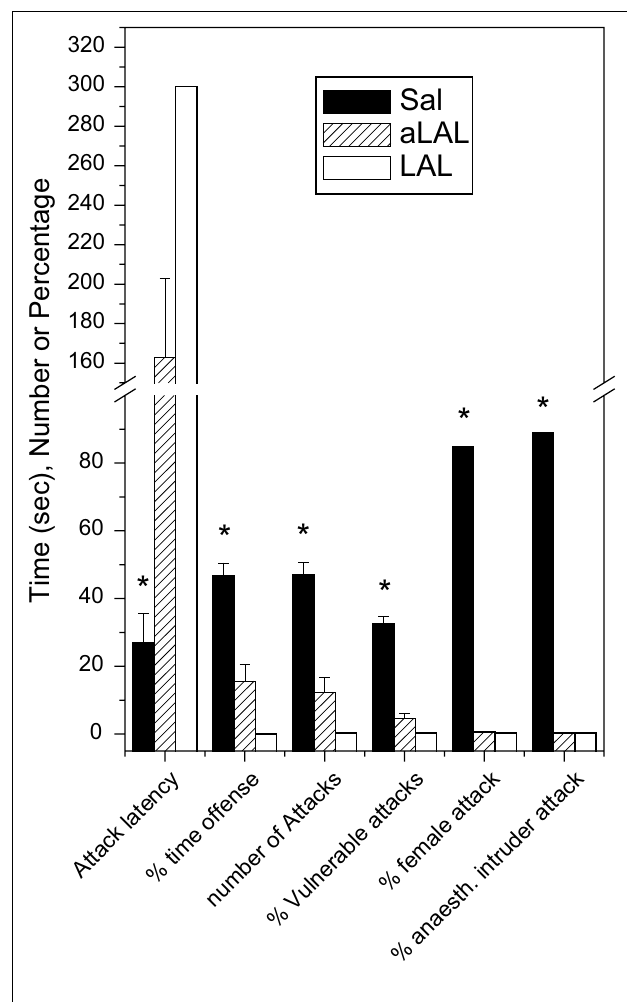
FIGURE 2 | ‘Violent’ aggressive behavioral characteristics in artifi cially- selected high-aggressive SAL mice ( n = 20) after four repetitive victorious experiences, and the normal- or non-aggressive behavioral performance in low-aggressive attacking group of LAL ( n = 8) and non-aggressive LAL mice ( n = 12). See Caramaschi et al., 2008 for methodological details of the mice resident-intruder offensive aggression test. * indicates signifi cantly ( p < 0.05; student t -test) different from the aLAL and LAL mice.